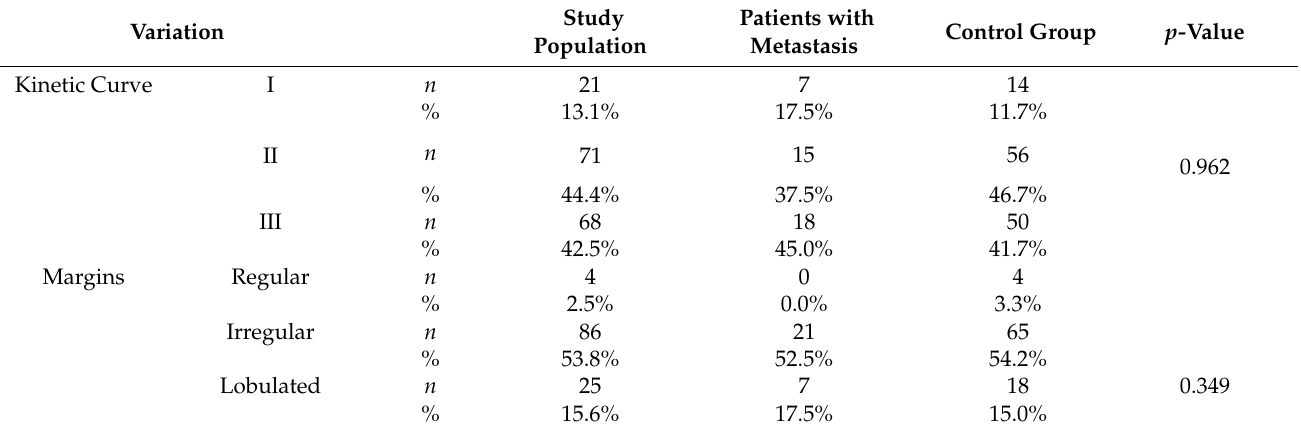
Table 1. Description of the extracted MRI